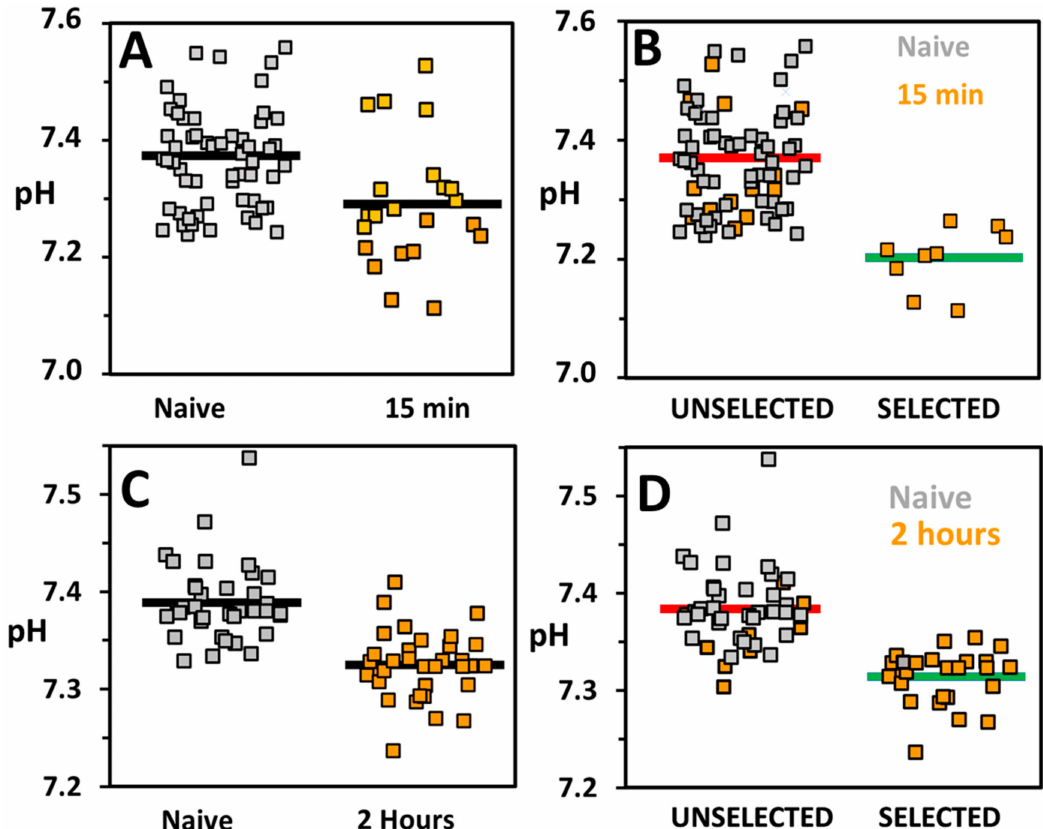
Figure 4. ( A ) pH of droplets containing CD4+ T-cells that are either naive (gray) or activated for 15 min (orange). Average pH values, indicated by a horizontal line, are 7.37 ± 0.01 ( n = 59) for naive cells and 7.26 ± 0.04 ( n = 22) for activated cells ( B ) Droplet presented as unselected and selected populations after sorting using SIFT device. While activated cells make up 27% of cells prior to sorting, selected cells contain exclusively activated cells. ( C ) pH of droplets containing naive (gray) or cells activated for 2 h (orange). Average pH values, indicated by a black line, are 7.39 ± 0.01 ( n = 37) for naive cells and 7.32 ± 0.01 ( n = 34) for activated cells. ( D ) Droplets presented as unselected and selected populations. The sorting of droplets leads to an enrichment of activated cells from 48% before sorting to 96% of selected